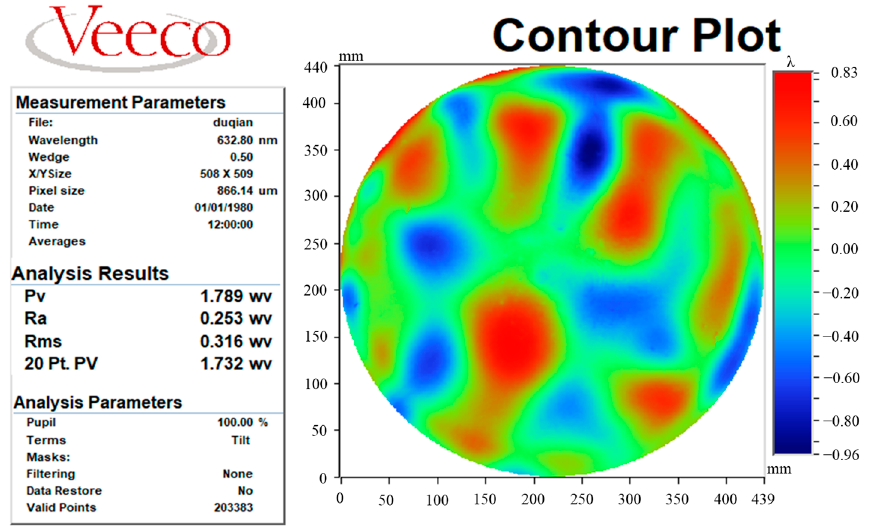
Figure 21. Photos of the rapid polishing process with center fl uid supply.